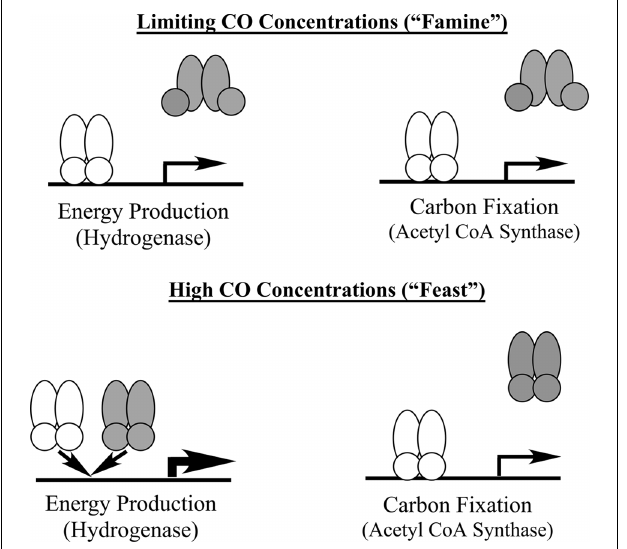
FIGURE 7 | Model of CooA mediated regulation of CO-utilization in C. hydrogenoformans .The shaded symbol represents CooA-1 and the shaded symbol represents CooA-2.When CO levels are high both CooA-1 and CooA-2 are in the CO-bound form. CooA-1 is then able to shunt more CO into energy production through overexpression of the hydrogenase, while CooA-2 continues to shuttle CO toward carbon fixation. Under limiting CO concentrations only CooA-2 is in the CO-bound state and can activate both energy production via balanced expression of the hydrogenase and carbon fixation